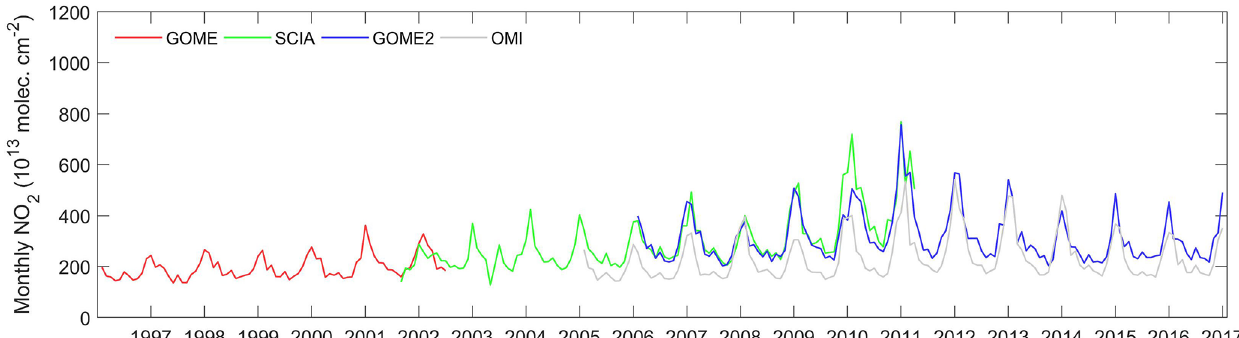
Figure 3. An example of the time series of the monthly NO 2 column retrieved by GOME, SCIAMACHY, GOME2 and OMI in China. We obtained the GOME, SCIAMACHY, GOME2 and OMI data from http://www.temis.nl/airpollution/no2.html, last access: 17 July